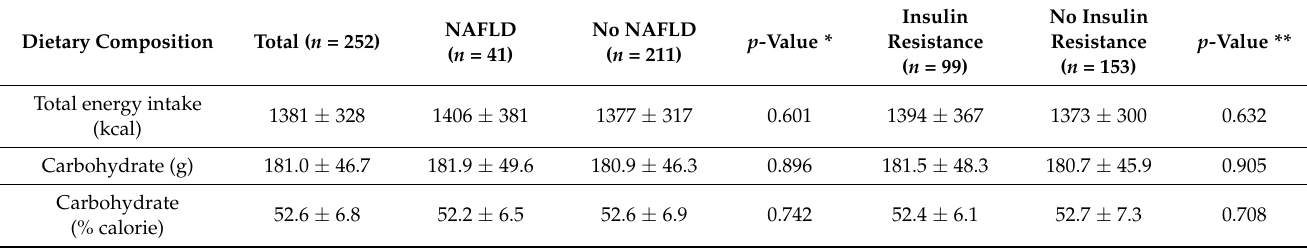
Table 2. Composition of daily dietary consumption in relation to NAFLD and insulin